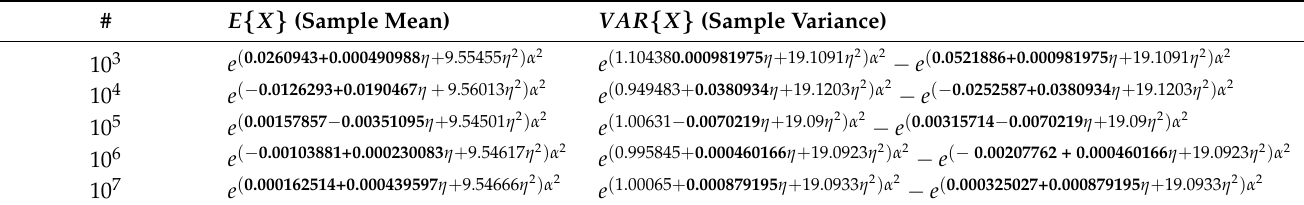
Table 3. Sample Mean and Sample Variance of the Euclidean LogNormal having a finite mean and α 2 + 9.54681 ) . The finite theoretical mean is infinite variance, obtained by setting σ = α and µ = ( − 1 2 ˘ E { X } = e 9.54681 , while the infinite theoretical variance is coefficients highlighted in boldface were zero, we would have obtained an almost perfect match between theory and practice.